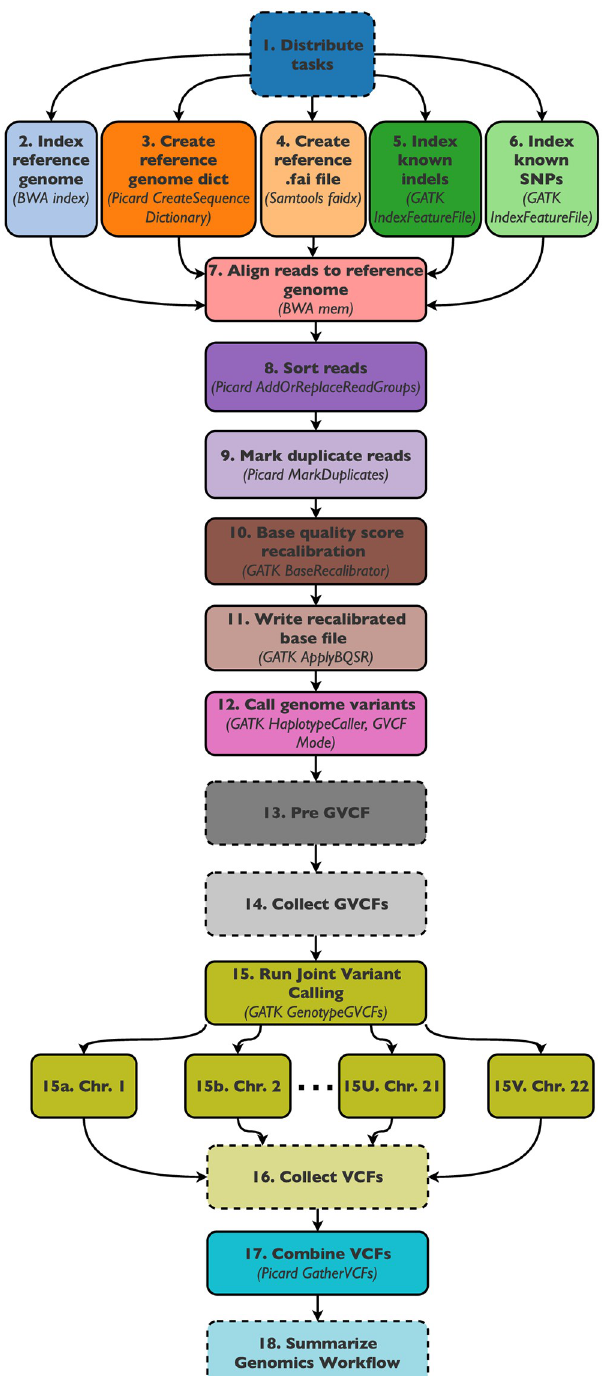
Fig 1. Joint variant calling workflow tasks. Diagram of the joint variant calling workflow as implemented in SWEEP. Dashed and solid edges represent function-based and container-based tasks, respectively.